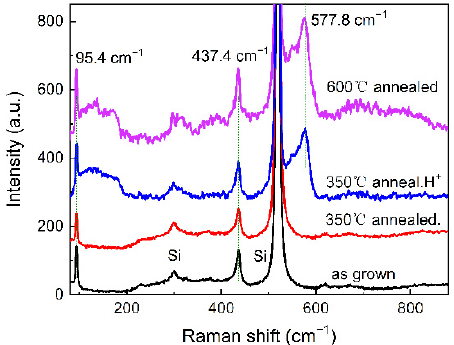
Figure 4. Raman spectra of ZnO nanorods.